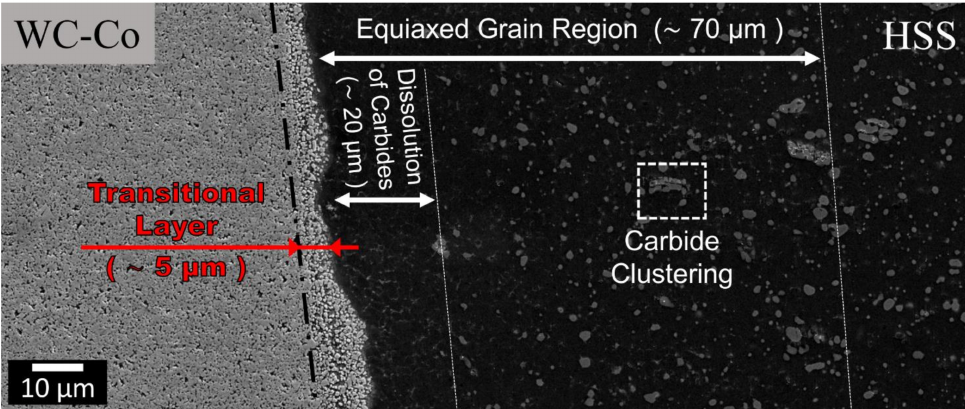
Figure 10. FESEM details of the W3 region in Figure 2. Evidence of a carbide dissolution region and an equiaxed grain region on the HSS side. Evidence of a transitional layer on the WC-Co side. The white rectangle indicates dissimilar HSS carbide